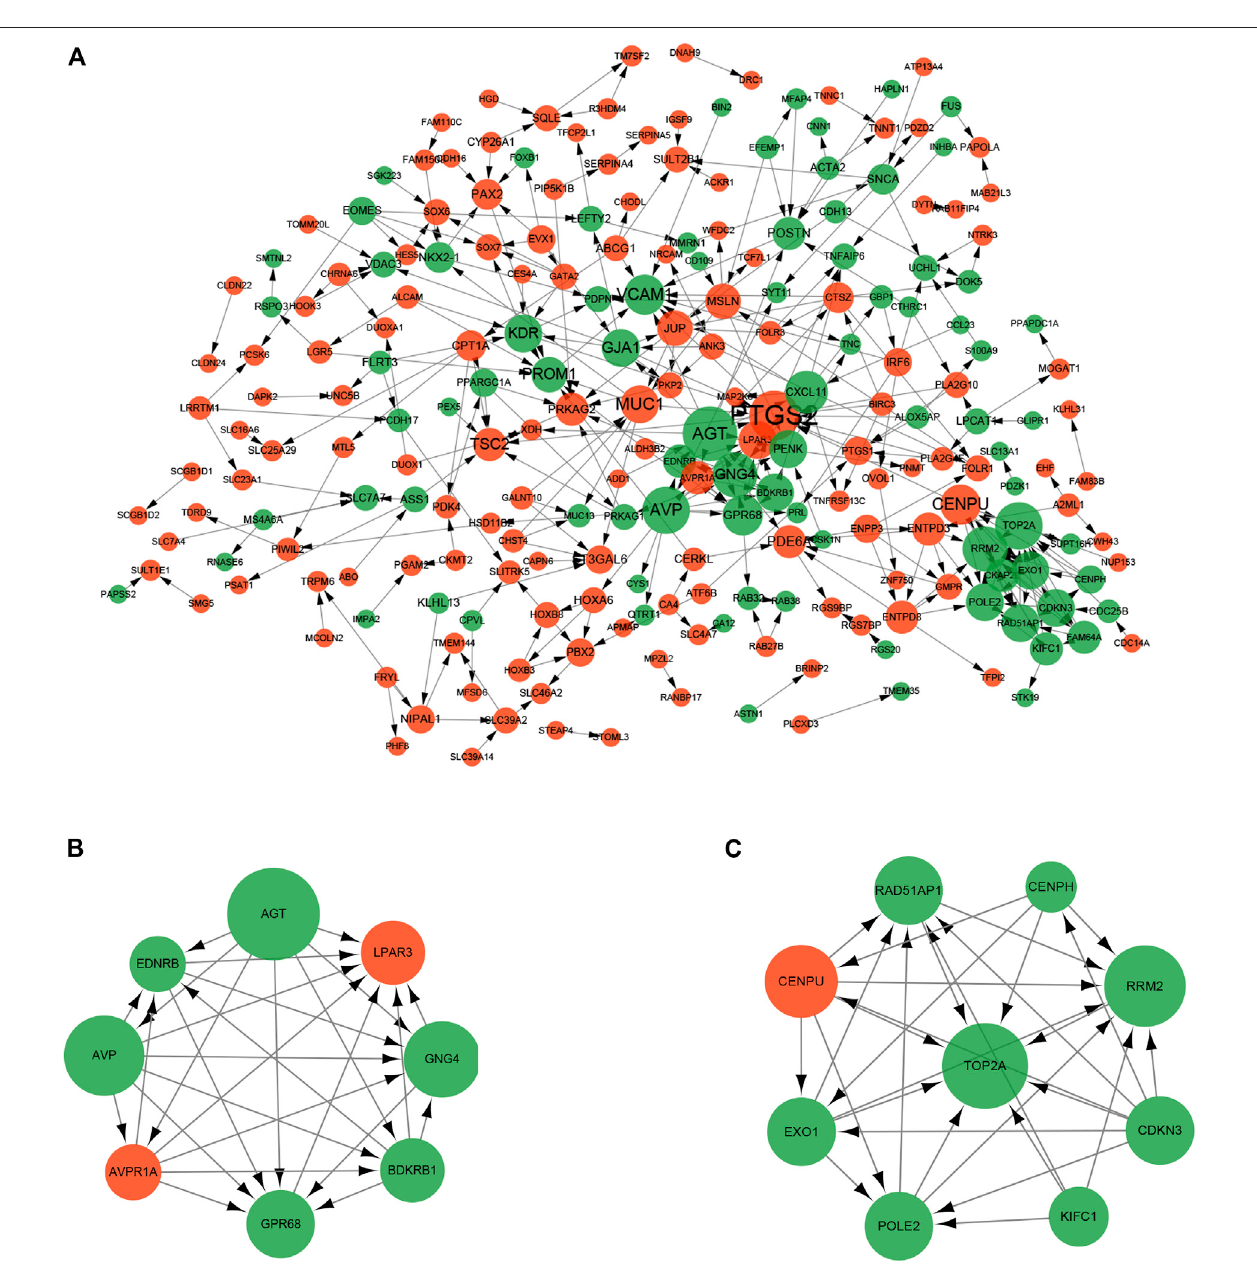
FIGURE 6 | Protein-protein interaction (PPI) network of DEGs. The size of the dot represents the degree of association of the node genes. The larger the dot, the greater the degree of genetic association. Red nodes and green nodes indicate upregulated and downregulated genes, respectively. (A) PPI network contained 229 nodes and 373 interaction pairs; (B) Sub-network module with the highest score in the PPI network; (C) Sub-network module with the second highest score in the PPI network.